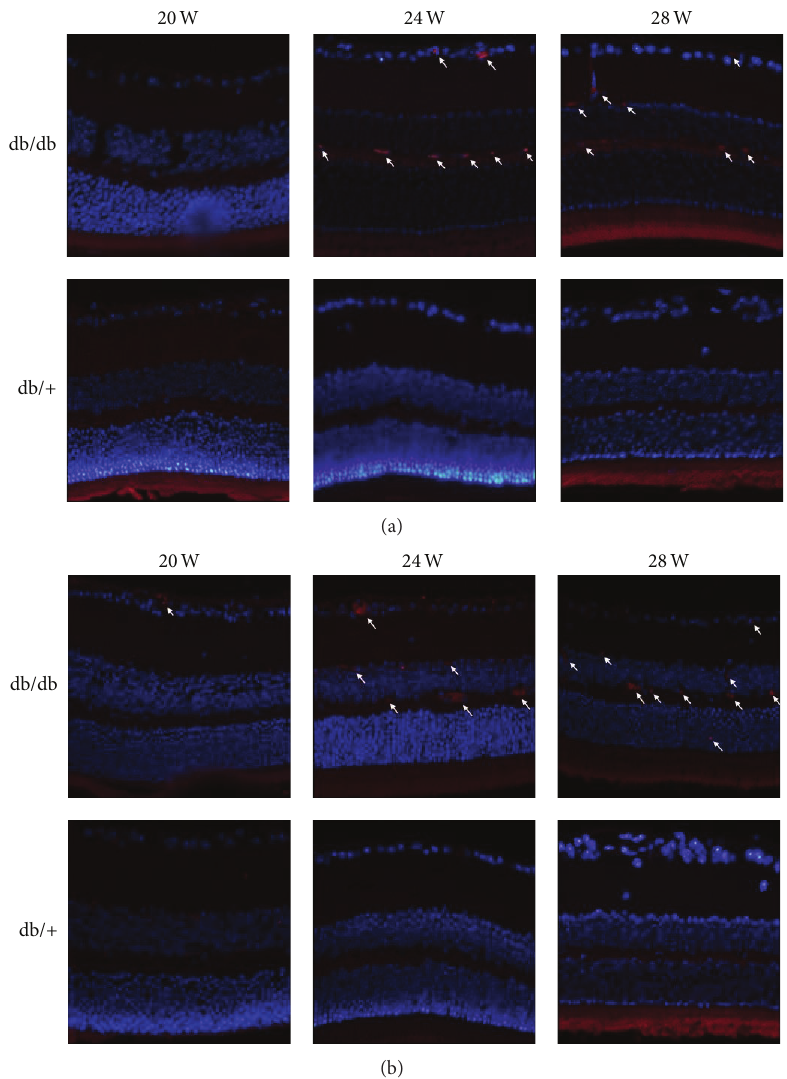
Figure 6: Effect of diabetic condition suffered the db/db mice on inflammoactivation in the retina. Representative immunofluorescence of Iba-1 ((a), 400x; microglia, macrophages) and F4/80 ((b), 400x; microglia, macrophages) was observed in db/db mice eyes at 24- and 28-week period compared with db/+ mice. No positive expression of the two markers was found in littermates eyes. Arrow represented the positive